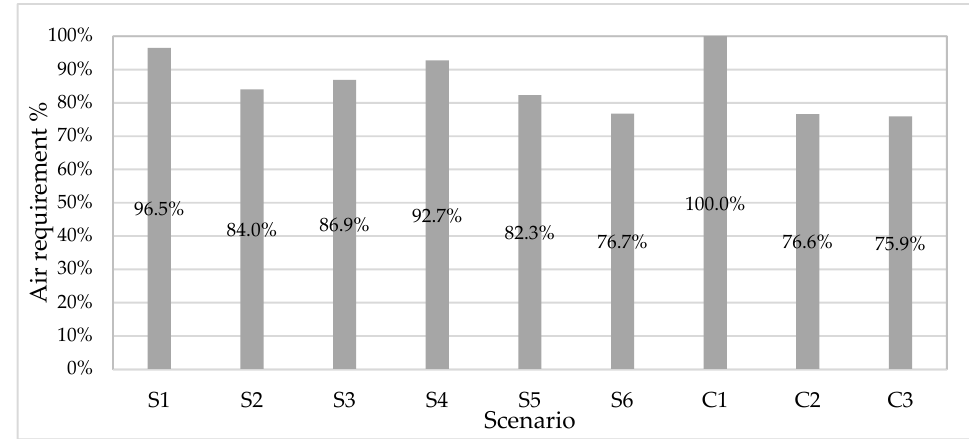
Figure 11. Air requirements of the tested strategies as percentage of the baseline scenario (Base).